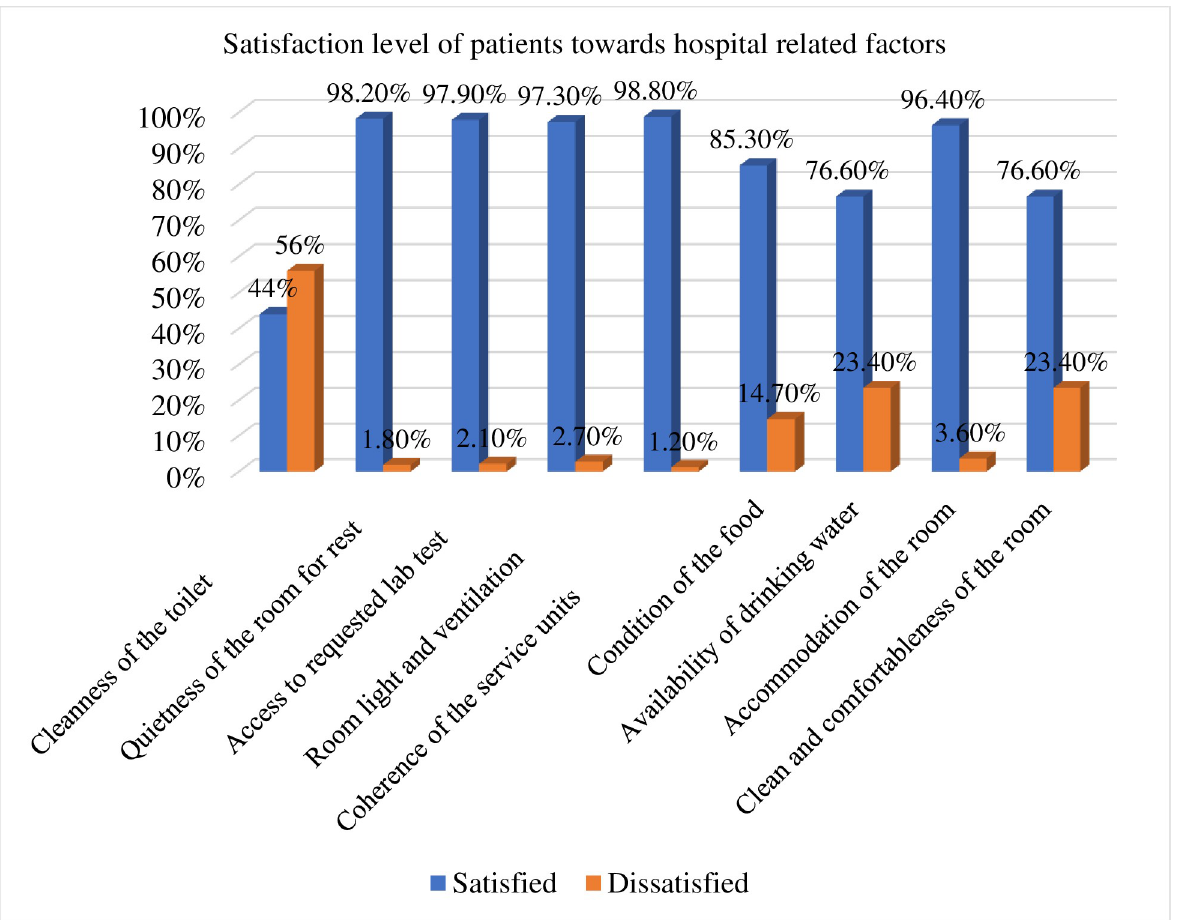
Fig 1. Satisfaction with hospital-related factors among patients admitted to Pawie General Hospital Benishangul Gumuze Region, West Ethiopia, 2020 (n = 334).